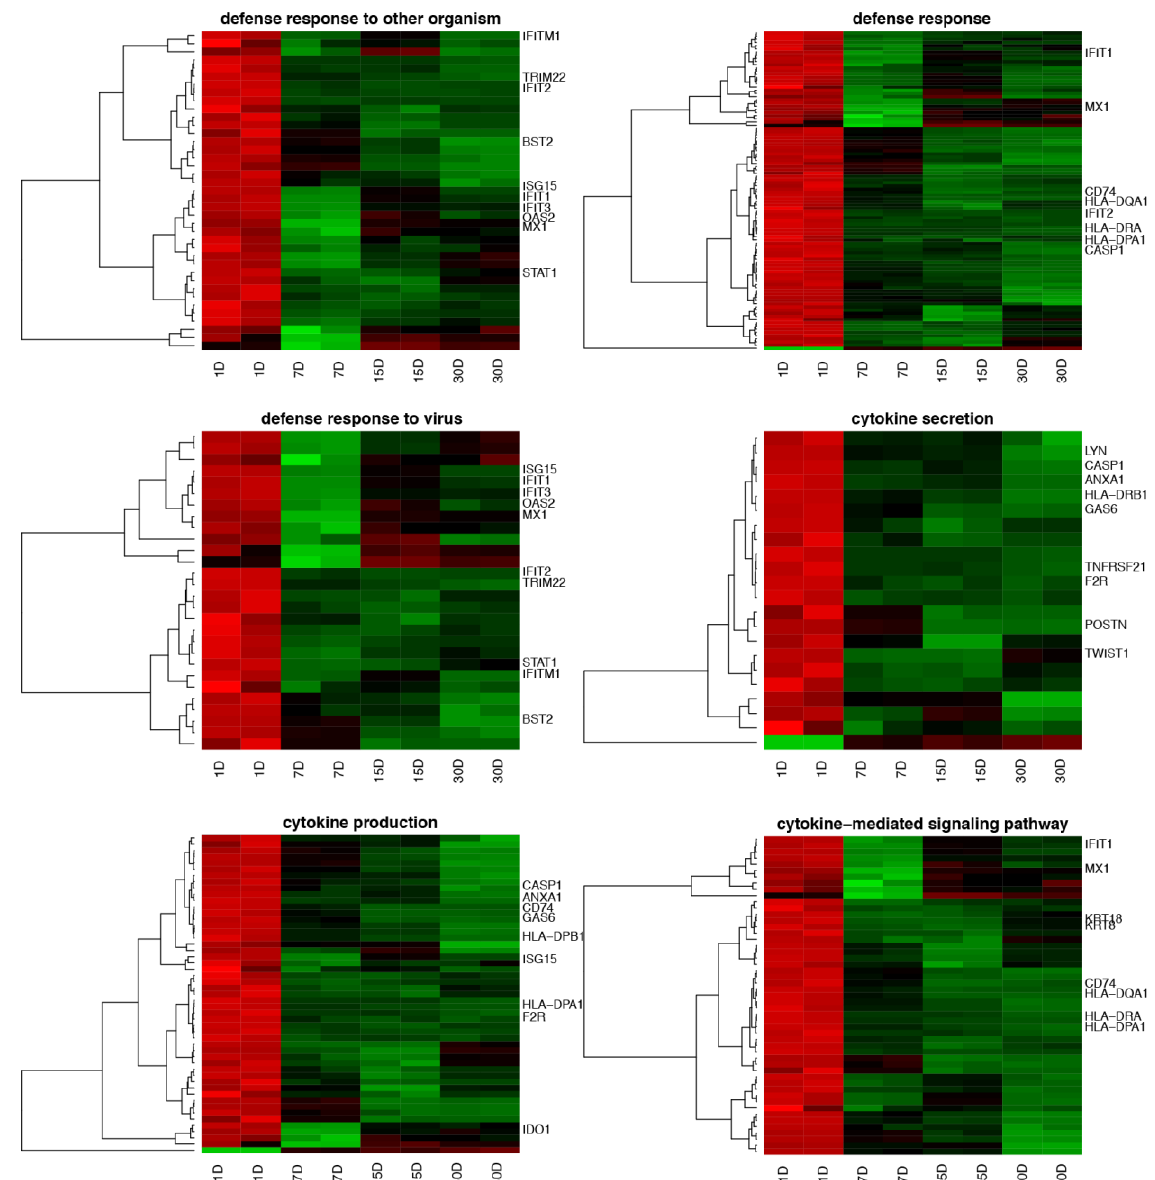
Figure 1 . Heatmaps presenting differentially expressed genes involved in “defense response to other organism”, “defense response”, “defense response to virus”, “cytokine secretion”, “cytokine production” and “cytokine-mediated signaling pathway”, based on GO BP terms. Each row on the Y axis represents a single transcript. The X axis presents the names of the samples, which are the same as the culture time point. The red color indicates downregulated and the green indicates upregulated genes at subsequent points of the analysis. The gene labels are limited to the 10 most changed in a given GO BP process.